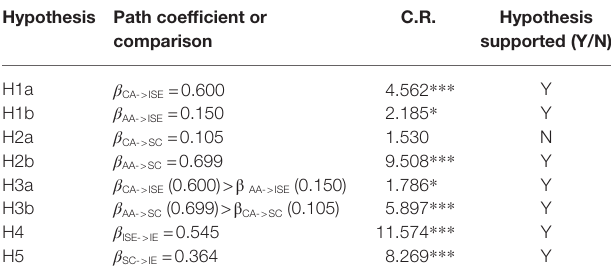
TABLE 3 | Results of hypotheses test. Hypothesis Path coefficient or comparison